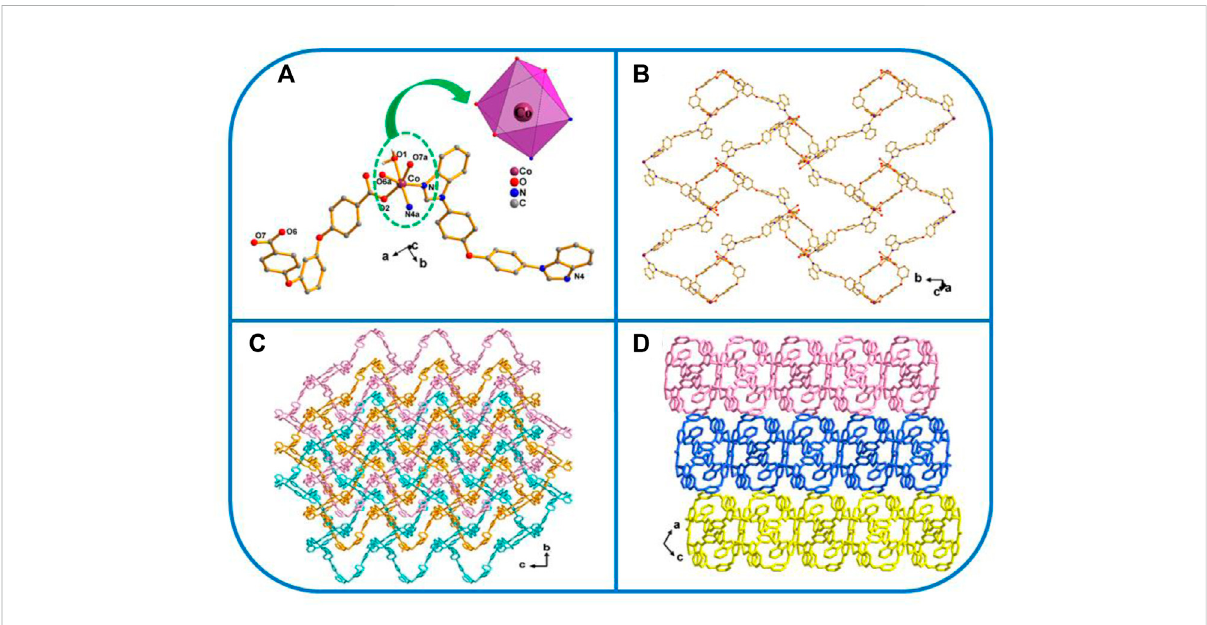
FIGURE 1 (A) Coordination unit of the Co ion in YMUN 1 ((hydrogen atoms are omitted for clarity), symmetry codes: (i) - x +2, - y , - z +1; (ii) x +1/2, - y +3/2, z +1/2; (iii) x -1/2, - y +3/2, z -1/2.); (B) view of the single 2D lamellar structure of 1; (C) view of the three-fold interpenetrating 2D strati fi ed network throughthe2Dlamellarstructureofonealongthe a axis;and (D) viewofthe3Dframeworkthroughthe2Dstrati fi ednetworkwith weakinteractions occurring along the b